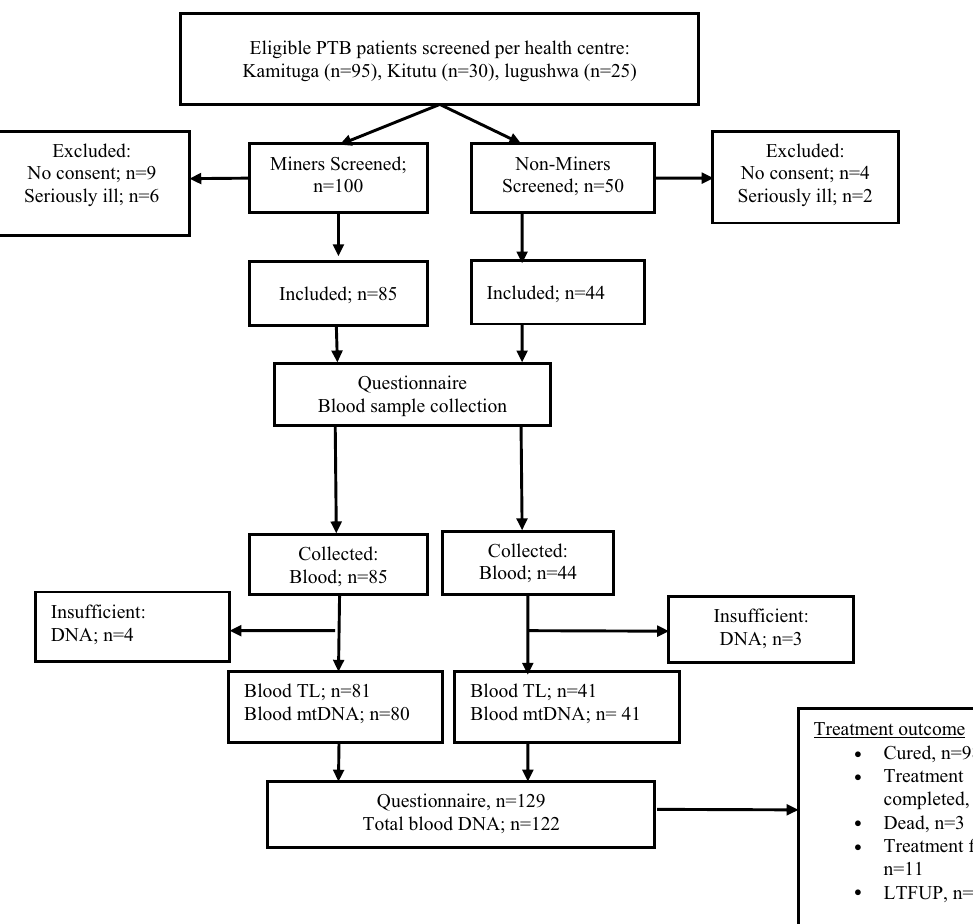
Figure 1. Study flow chart. PTB pulmonary tuberculosis, TL telomere length, mtDNA mitochondrial